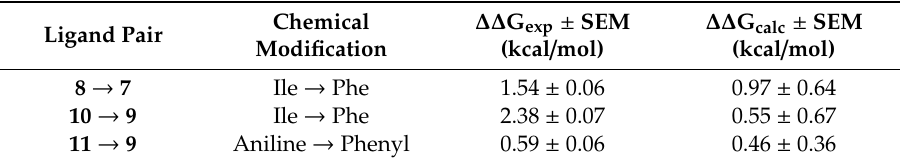
Table 1. Relative binding a ffi nity (in terms of experimental and calculated shifts in the free energy of binding) between three pairs of AT2